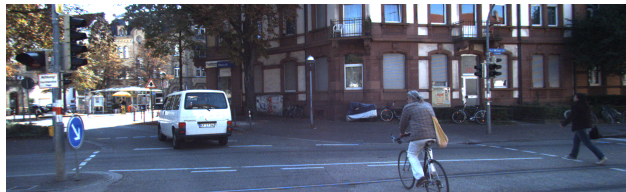
Figure 4. Sequence ‘5’ from the KITTI raw